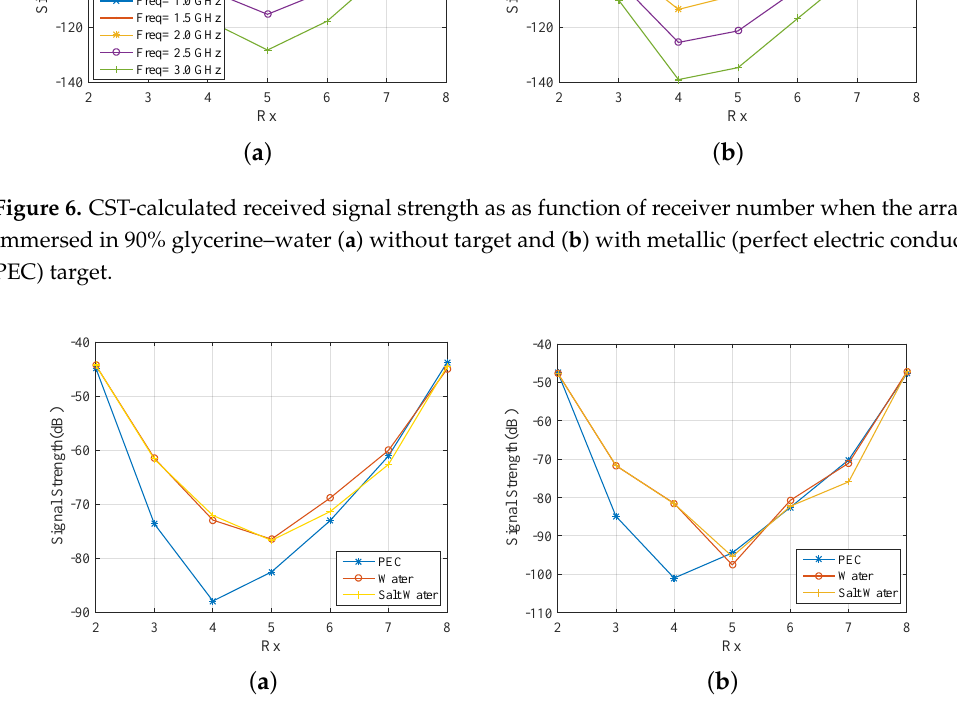
Figure 7. Comparison of the impact of a metallic (PEC), water, and salt–water cylindrical target when the array is immersed in 90% glycerine–water: Received signal strength as a function of receiver number ( a ) at 1.0 GHz and ( b ) at 1.5 GHz.